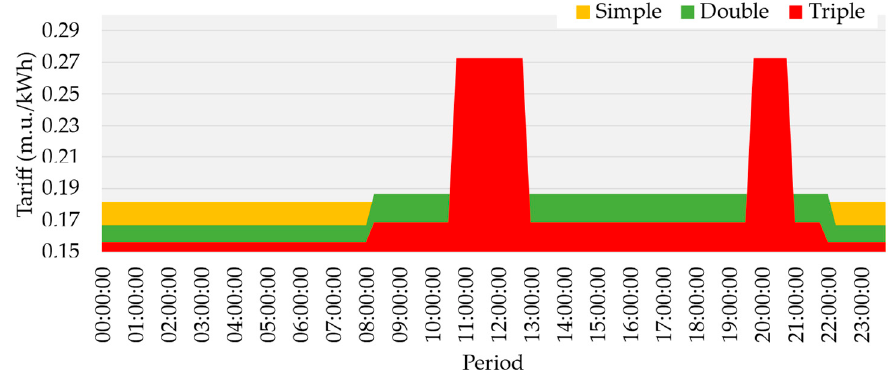
Figure 4. Schedule for the different tariffs.